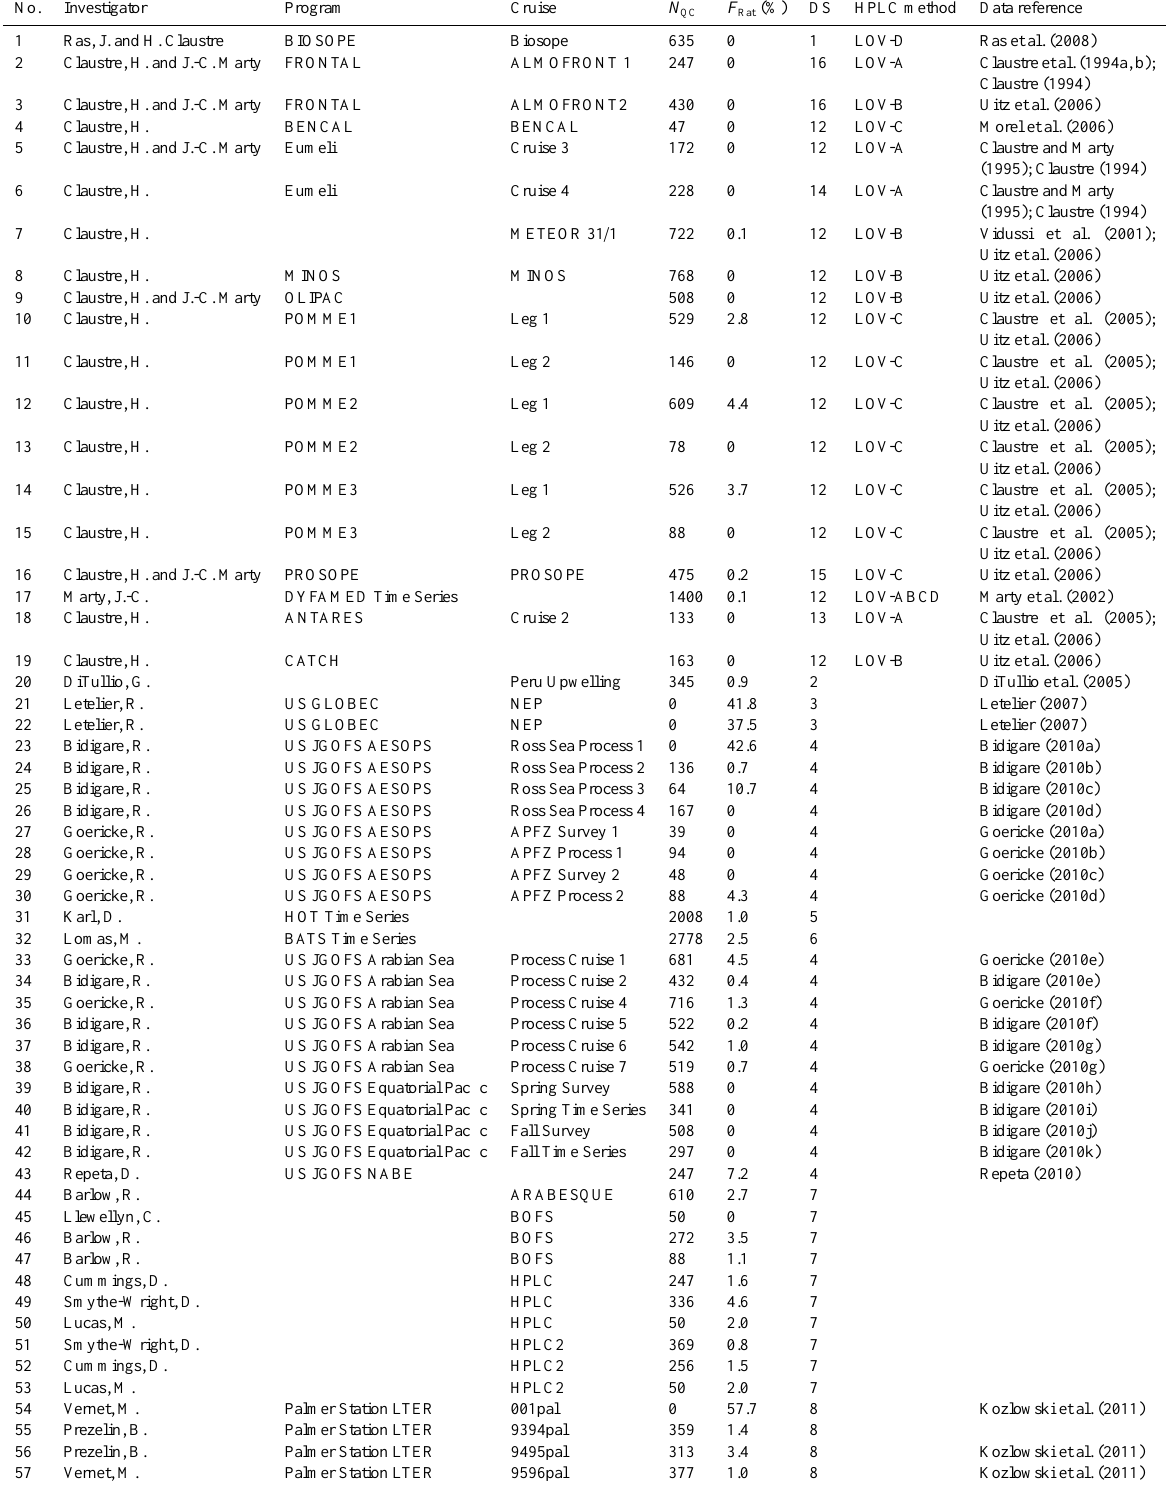
Table 1. Summary of pigment sample contributions to MAREDAT. N QC represents the number of quality-controlled samples each contribu- tion submitted to the dataset. F Rat represents the percentage of samples that were removed due to values outlying two standard deviations of the TCHLA vs. TACC linear relation. DS represents the data source, for which numerical values correspond to definitions below the table. No.